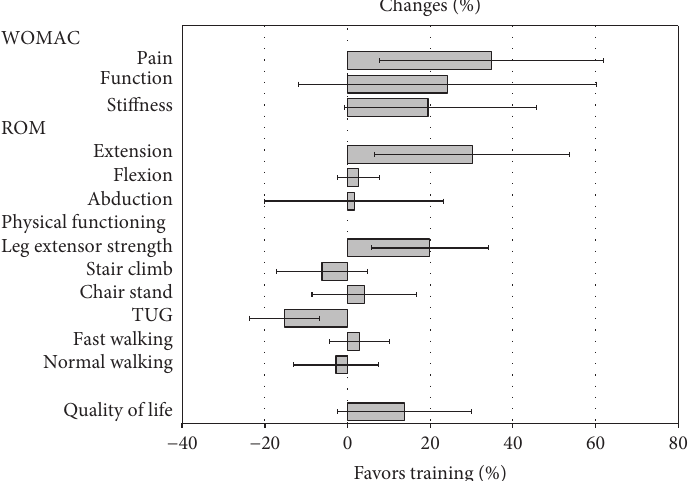
Figure 1: Mean changes (95% CI) in the main outcome variables in 12 weeks.